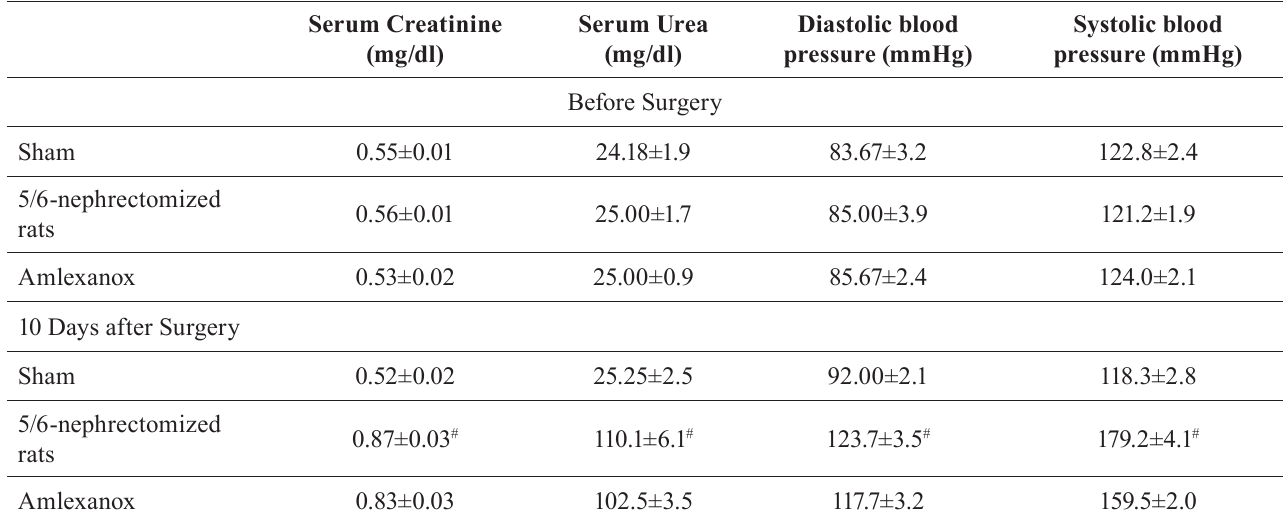
Values are expressed as mean± SE (n= 6). Amlexanox (25mg/kg/day) was given i.p. Statistical analysis using Two-way ANOVA, followed by Bonferroni’s Post-test. #P < 0.05 vs.